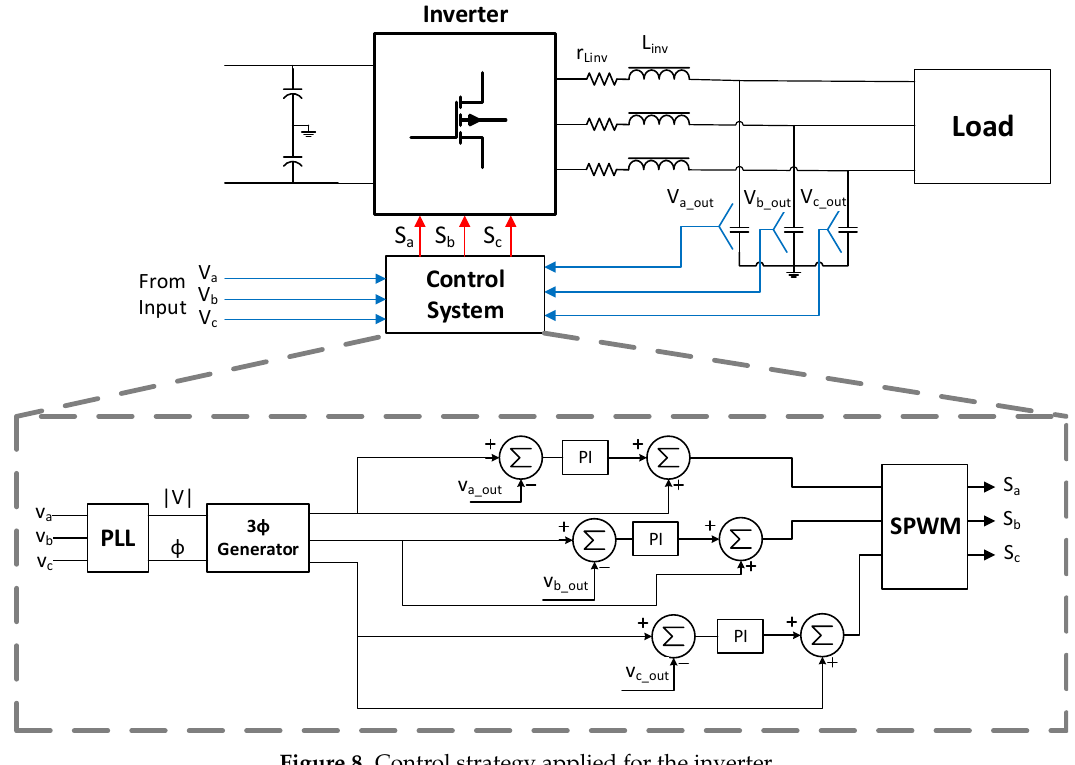
Figure 8. Control strategy applied for the